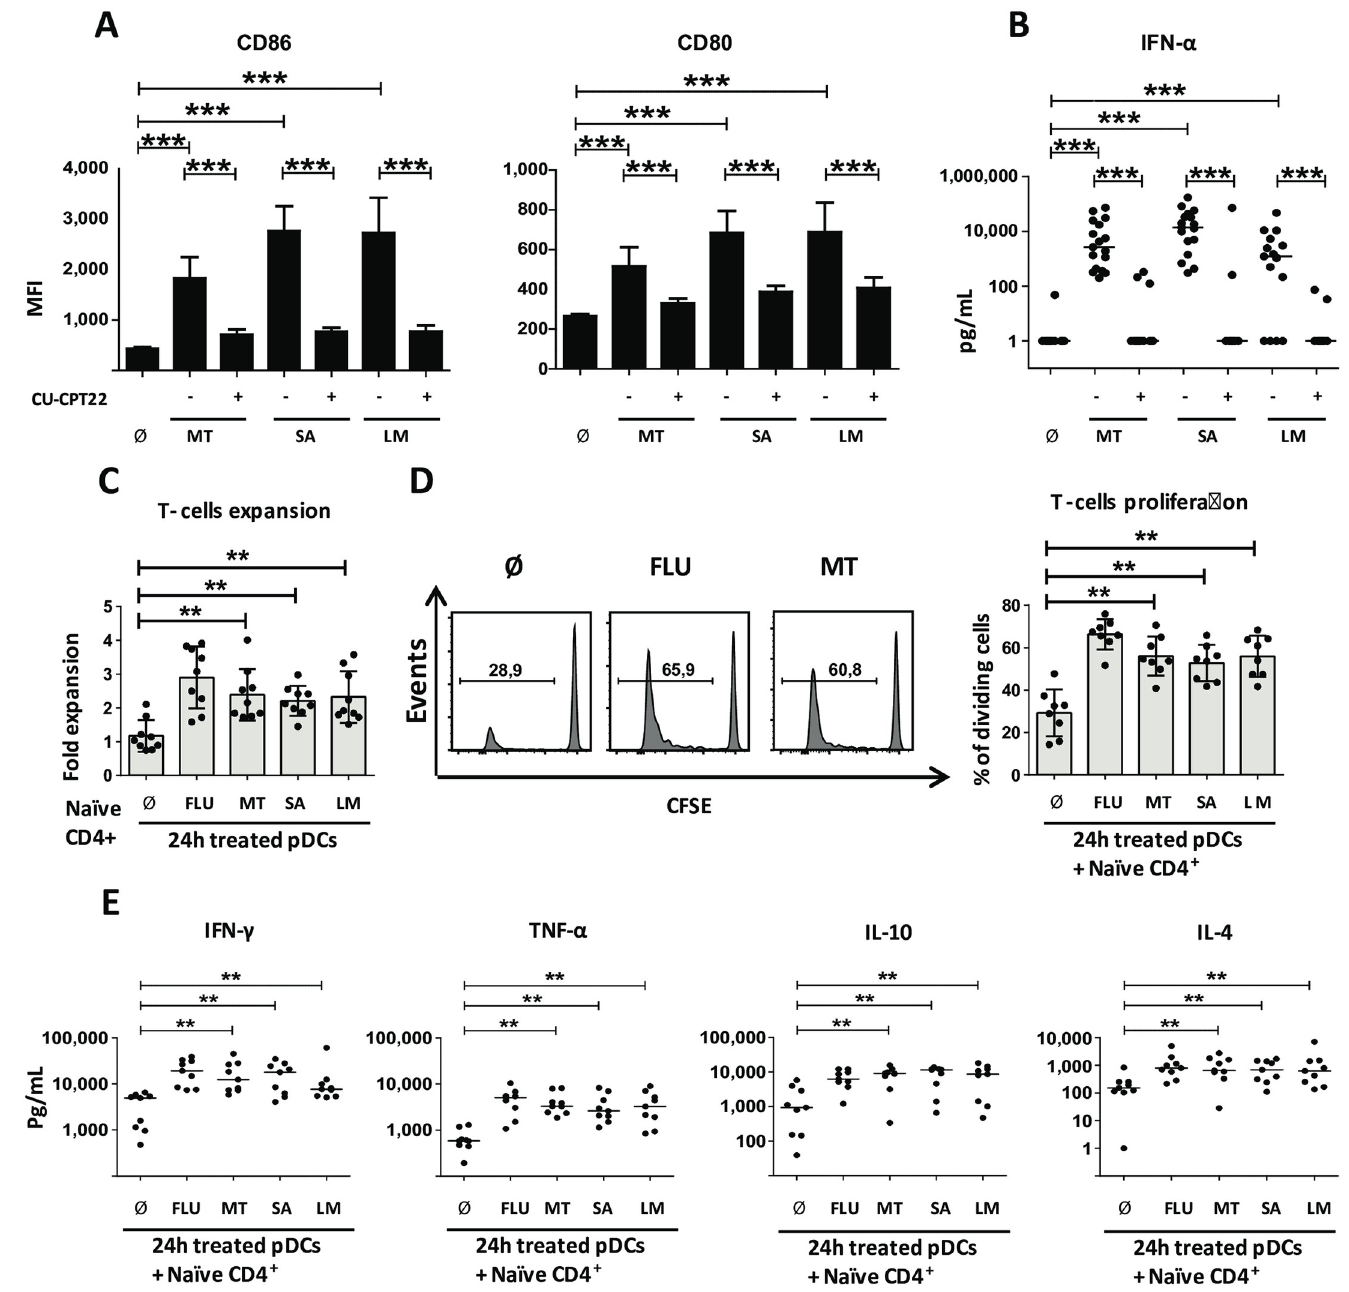
Fig 2. pDCs sense different gram+ bacteria through TLR1/2 pathway. (A–B) Sorted human blood pDCs were cultured during 24 hours with medium either without ( Ø ) or with: heat-killed MT, heat-killed SA, or heat-killed LM and in presence (+) or absence ( − ) of CU-CPT22. (A) MFI for surface expression of costimulatory molecules from activated pDCs. Results include the mean of 27 independent donors. (B) Cytokine secretion by pDCs. Results include 17 independent donors. (C–D) Allogeneic CD4 + naive expansion and percentage of dividing living cells after 6 days of coculture with 24-hours gram + -stimulated pDCs. FLU activated pDCs were used as a control. Results include the mean of 9 donors. (E) Th cytokine pattern from gram+ pDCs activated T-cell coculture. Cytokines were measured after 24 hours polyclonal restimulation of the T cells. Results include the mean of 9 independent donors. Each dot represents a donor. � p < 0.05; �� p < 0.01; ��� p < 0.001 (Wilcoxon test). Underlying data for this figure can be found in S1 Data. CD, cluster of differentiation; FLU, influenza virus; LM, Listeria monocytogenes ; MT,